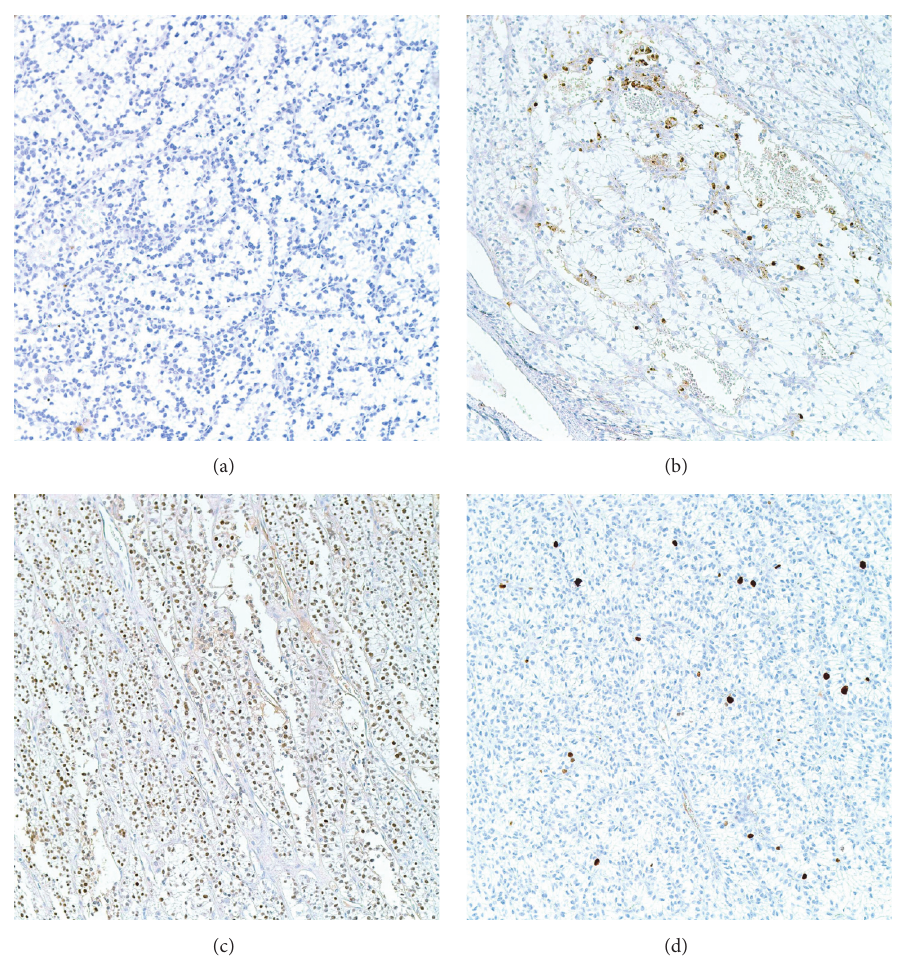
Figure 4: (a) Thyroglobulin stain negative. (b) Focally weakly positive parathyroid hormone stain. (c) Negative PAX8 stain. (d) KI 67 showing low mitotic